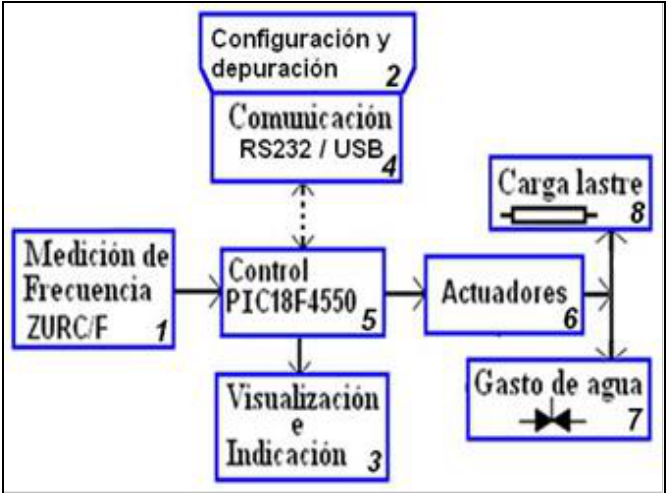
Figura 1: Esquema en bloques del prototipo con PICs, del regulador de frecuencia para las PCHs aisladas. Fuente: Los Autores,